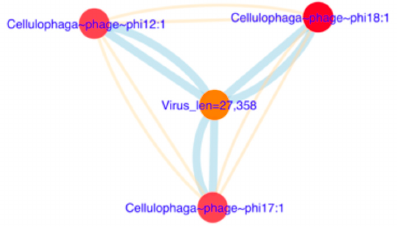
Figure 8. Protein-sharing network of genome of Cellulophaga phage. Yellow lines indicate strong similitarity, and blue lines indicate weak similarity. Thus, the virus of length 27,358 bp could be a novel virus.